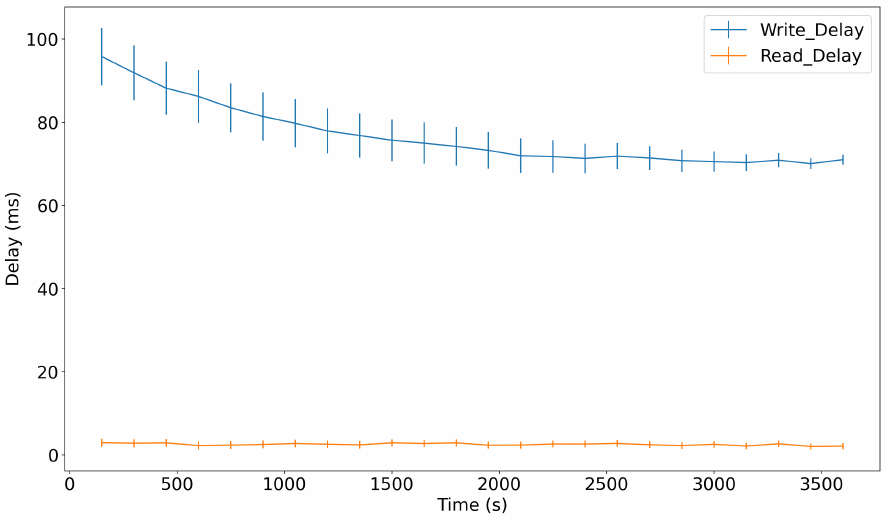
Figure 8. ReadDelay and WriteDelay with fixed values of N W = 18 and N R =